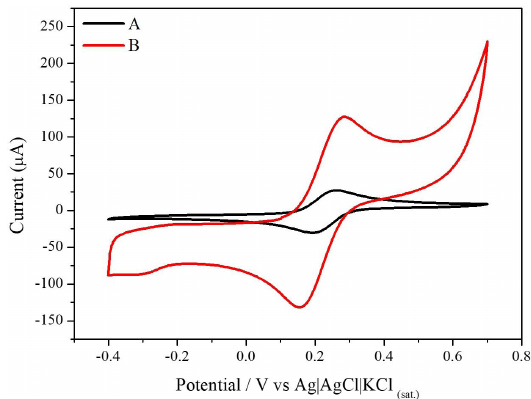
Figure 2. Voltammetric profile of the ferri-ferrocyanide couple at 20 mmol L -1 using (A) GCE and (B) reduced graphene oxide modified GCE, at 0.1 V s -1 scan rate.